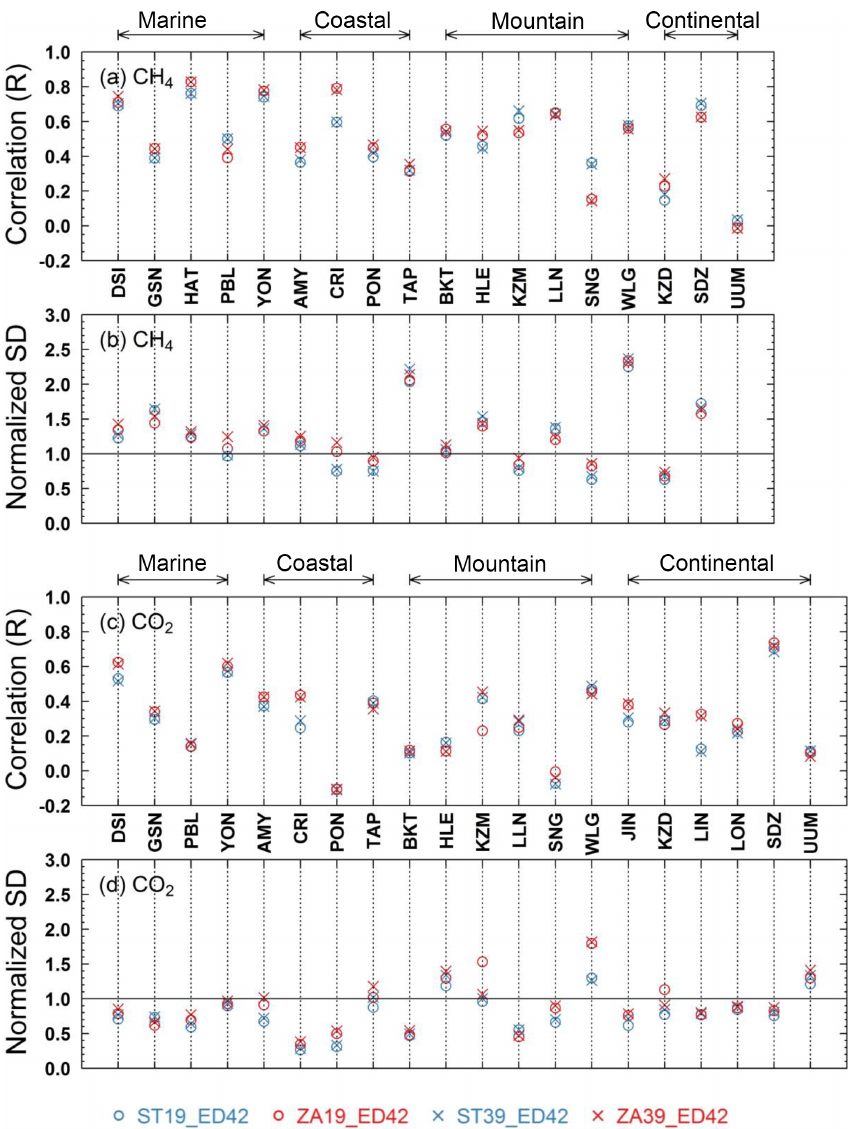
Figure 4. The correlations and normalized SDs between the simulated and observed synoptic variability for CH 4 (a, b) and CO 2 (c, d) at stations within the zoomed region. For each station, the synoptic variability is calculated from residuals from the smoothed fitting curve.